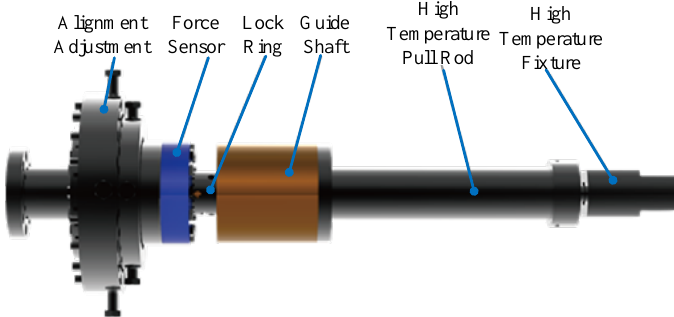
Figure 3. Composition of the loading connection structure.